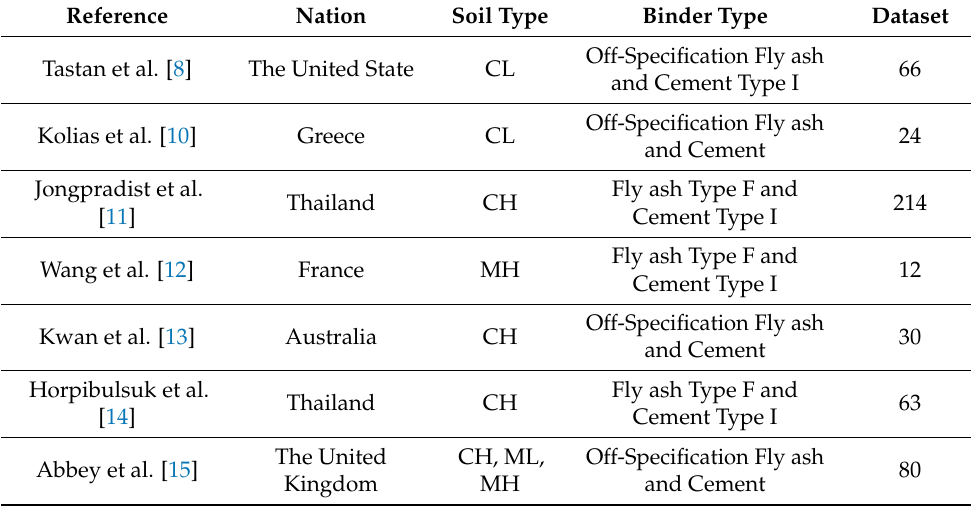
Table 1. Sources of data.